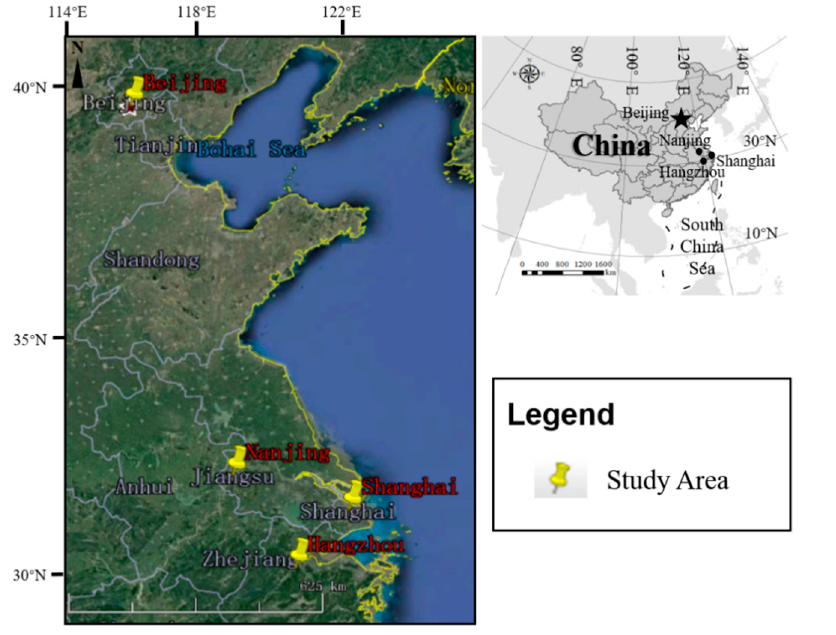
Figure 3. Study areas of the questionnaire survey.